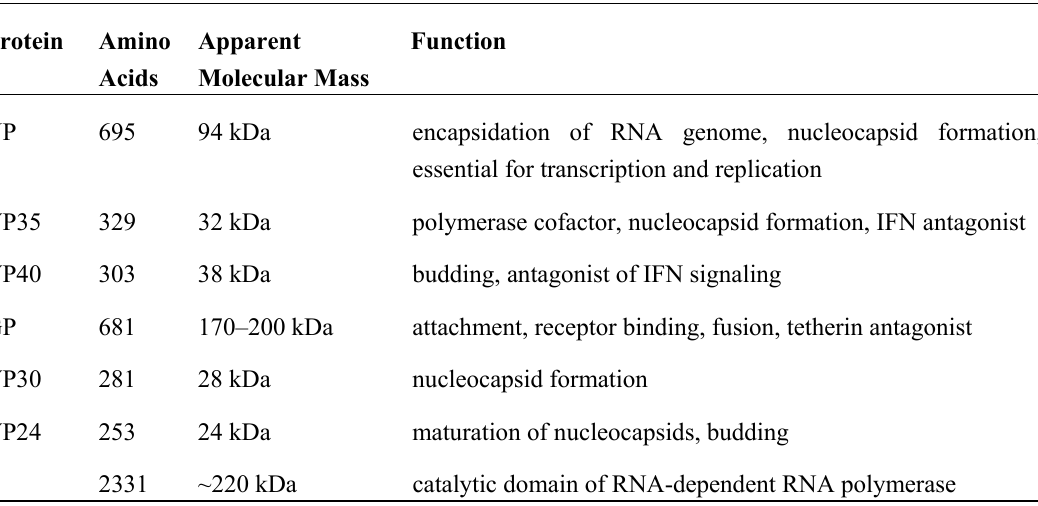
Table 2. MARV proteins and their function. The apparent molecular mass refers to the migration pattern of the proteins in SDS polyacrylamide gel electrophoresis and in some cases is different to the predicted molecular